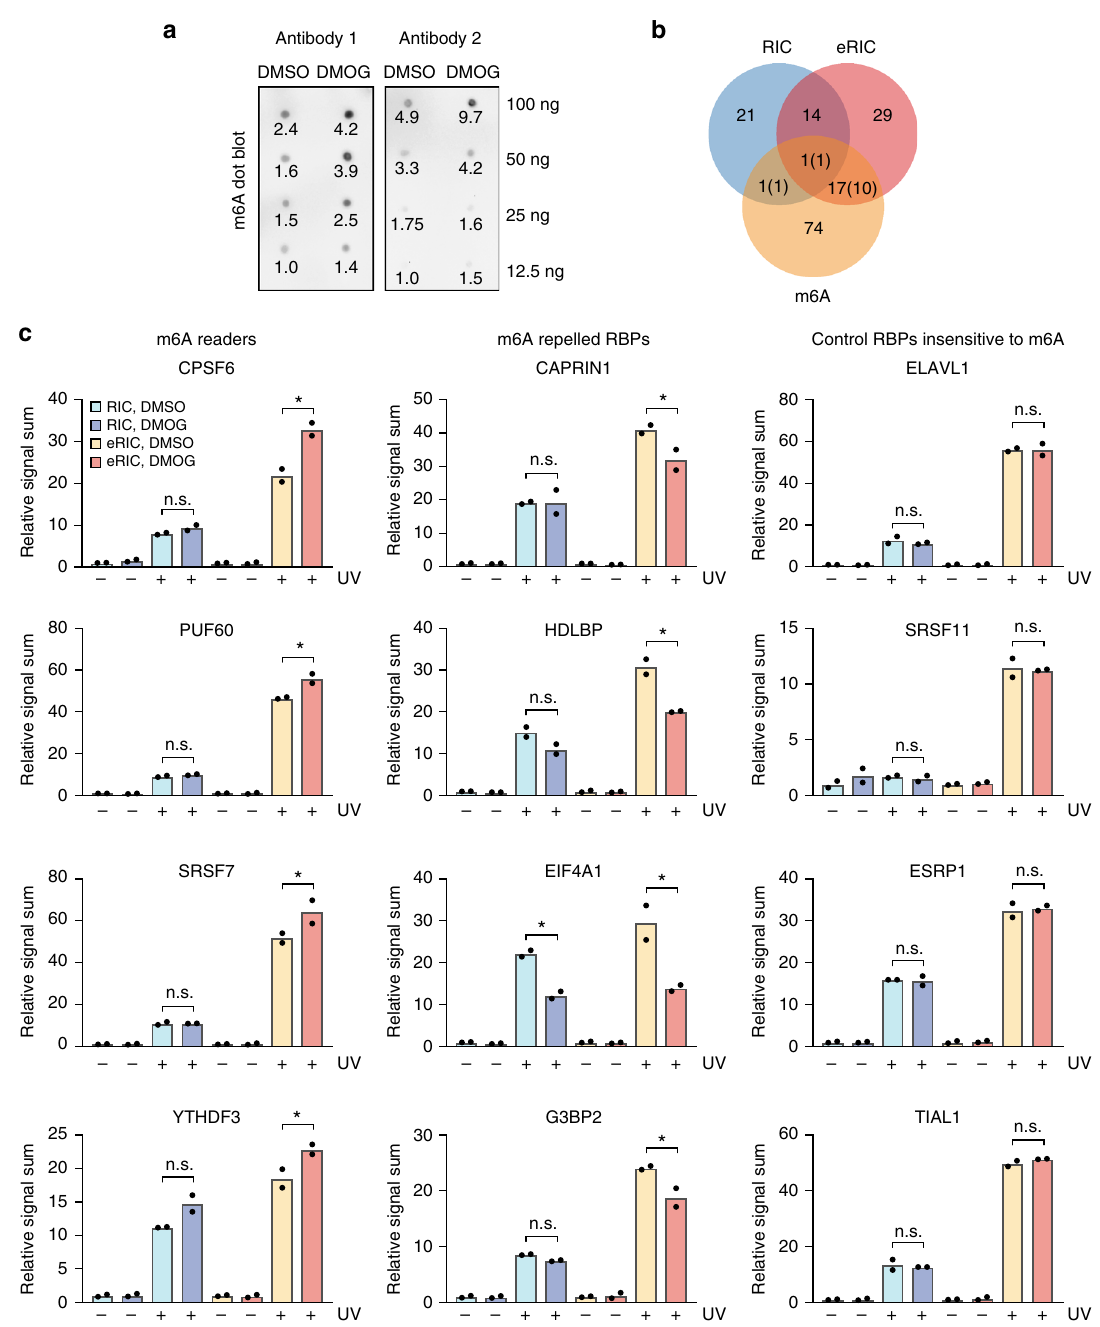
Fig. 7 eRIC identi fi es m6A-responsive RBPs in vivo. a m6A dot blot of Jurkat cells treated with 0.5 mM DMOG or vehicle for 6 h, using two independent antibodies (Antibody 1: Abcam, Antibody 2: SySy). Serial dilutions of poly(A) RNA were blotted as indicated on the right. A quanti fi cation of the signal intensity based on image analysis is shown below each dot. Intensity is expressed relative to the lowest signal in the control. A representative blot of three biologically independent experiments is shown. b Overlap between DMOG-responsive RBPs identi fi ed by eRIC/RIC and m6A-regulated RBPs previously reported by Edupuganti et al. 21 or Arguello et al. 20 . Between brackets are the number of proteins with directions of DMOG-induced changes that coincide with previous reports. c Normalized signal sum in eRIC and RIC samples of representative examples of reported m6A readers (left), m6A-repelled RBPs (middle), and RBPs insensitive to m6A (right). − UV non-irradiated controls, + UV irradiated samples. eRIC and RIC values are expressed relative to the respective untreated control ( − UV, DMSO). Data are shown as mean from two biologically independent experiments. Asterisk (*) indicates FDR < 0.05 (moderated t